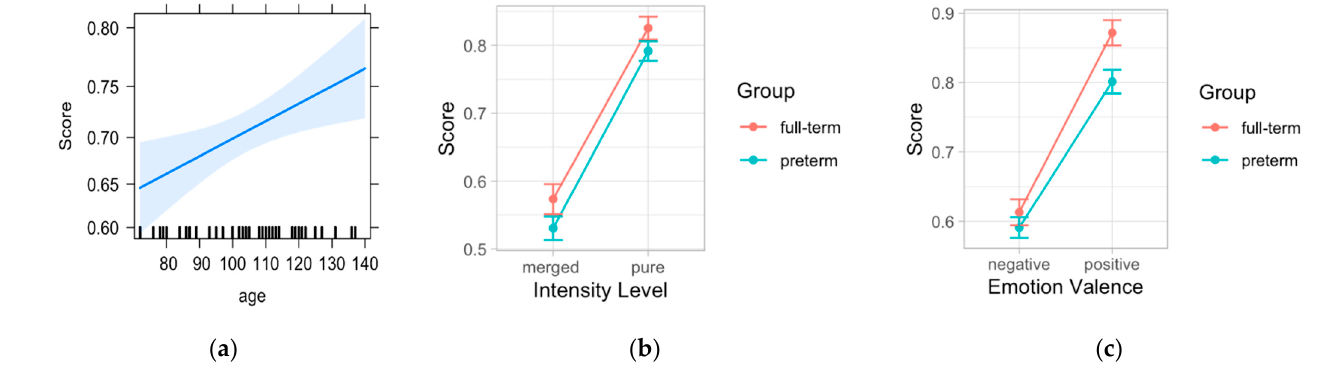
Figure 3. Plot of the main effects of age ( a ), intensity ( b ), and valence ( c ). The graph ( c ) shows also